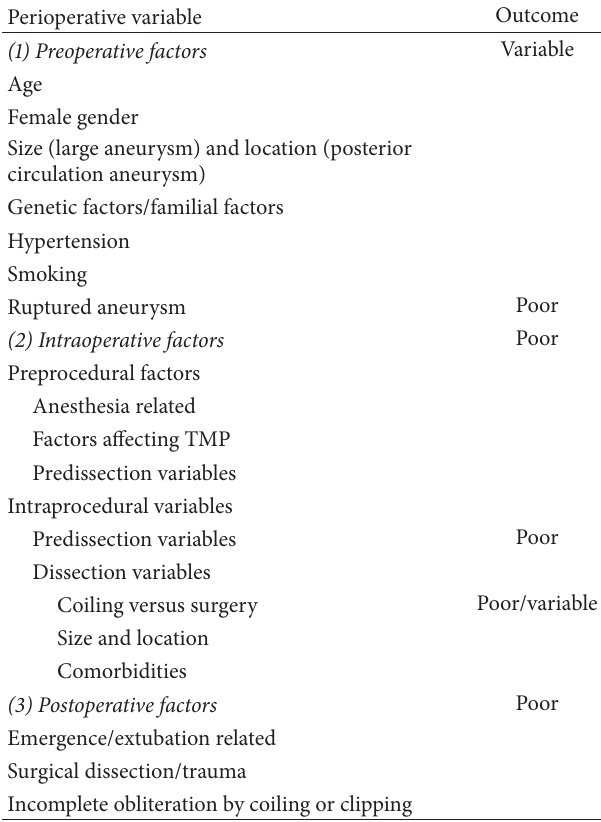
Table 3: Perioperative variables contributing intracranial aneurysm